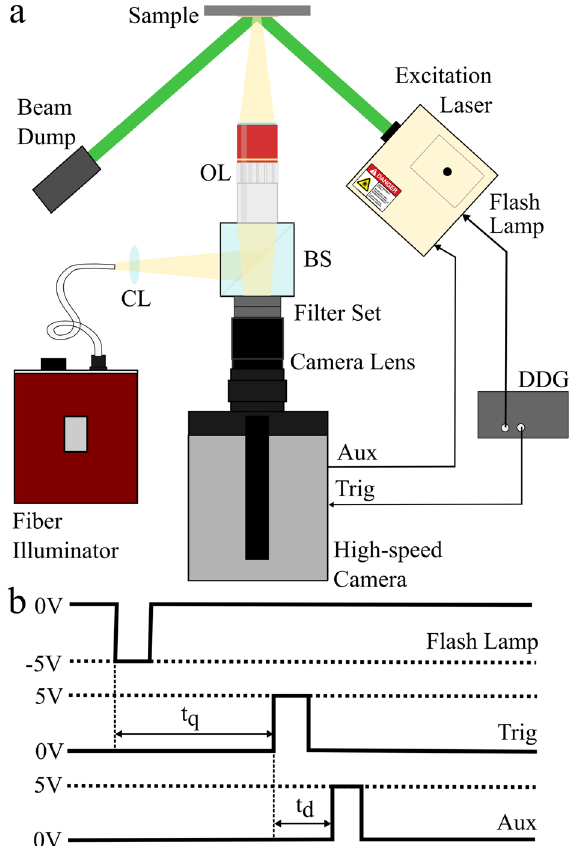
Figure 5. ( a ) Experimental set-up. OL, objective lens; DDG, digital delay generator; CL, collimating lens; BS, beamsplitter. ( b ) Timing diagram for synchronizing camera capture with excitation laser pulsing, top: signal to initiate flash lamp laser pumping; middle: Q-switch time-delayed signal to initiate camera acquisition; bottom: nanosecond-delayed signal to trigger a laser